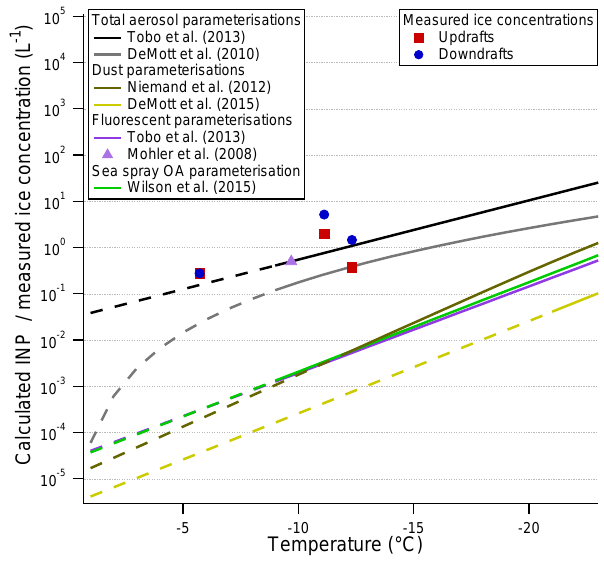
Figure 10. Comparison of INP calculations using different parame- terisations. The solid lines show the temperature ranges in which the INP parameterisations are deemed valid, while the dashed lines are extrapolations. The inland aerosol measurements were used as input for the parameterisations, other than for Wilson et al. (2015), where the marine OA concentration was used. The blue and red markers show measured first ice concentrations from 3 August (Taylor et al., 2016) at different cloud-top